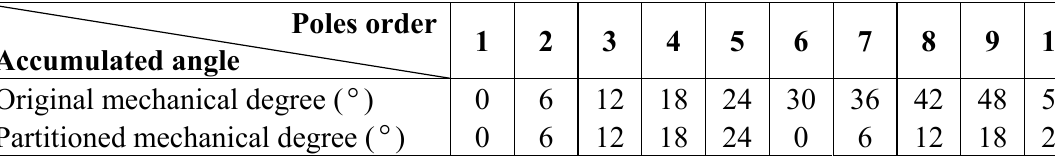
Table 1. Accumulated angle of 10-pole, 12-slot PMSM.